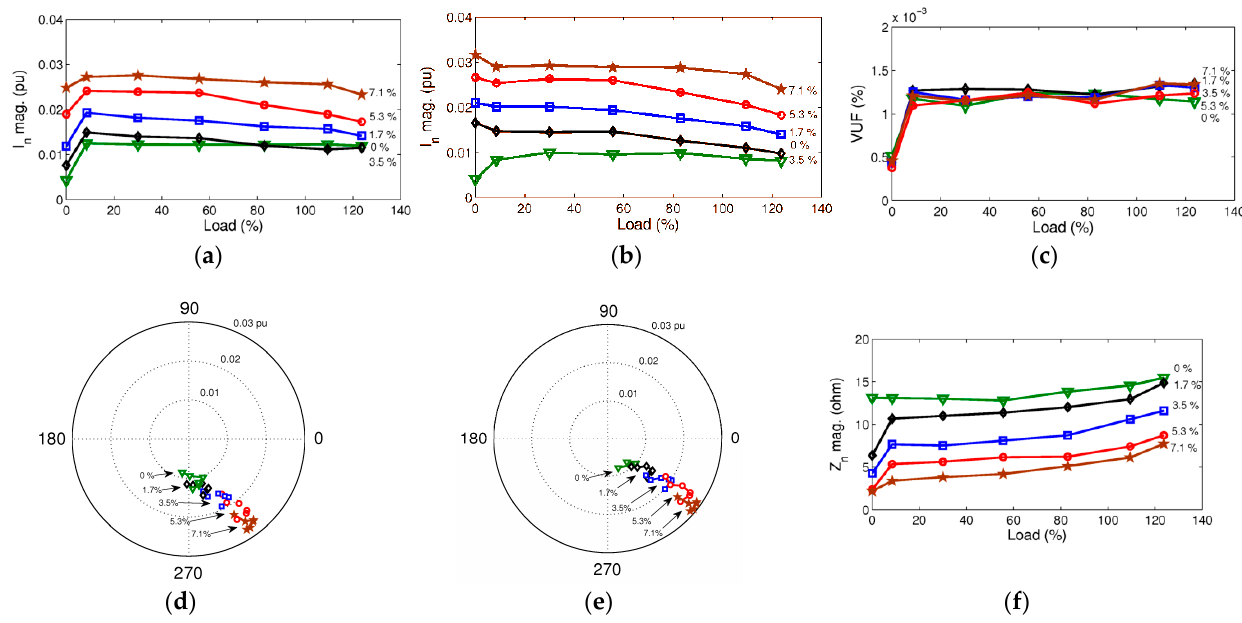
Figure 14. The experimental (symbols) and simulated (solid lines) results at varying shorted turn fault levels of 1.7%, 3.1%, 5.3% and 7.1%: the magnitudes of the positive and the negative sequence currents ( a ) and the negative sequence phasor trajectory for faults in two phases ( b ).